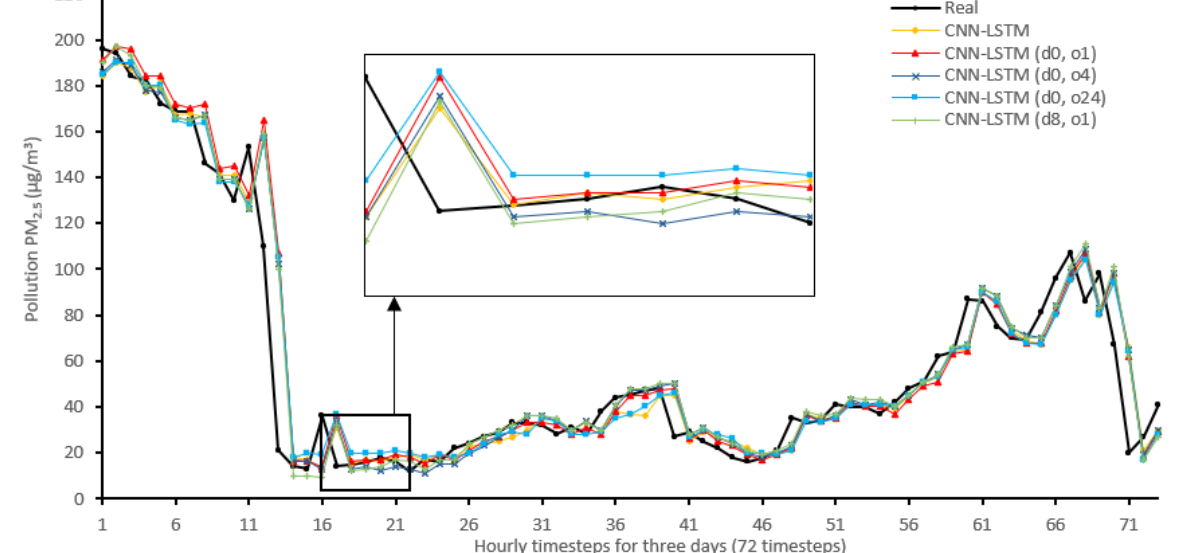
Figure 14. Real vs. CNN – LSTM and its NARX variants in part of the seventh iteration results for the Beijing dataset.